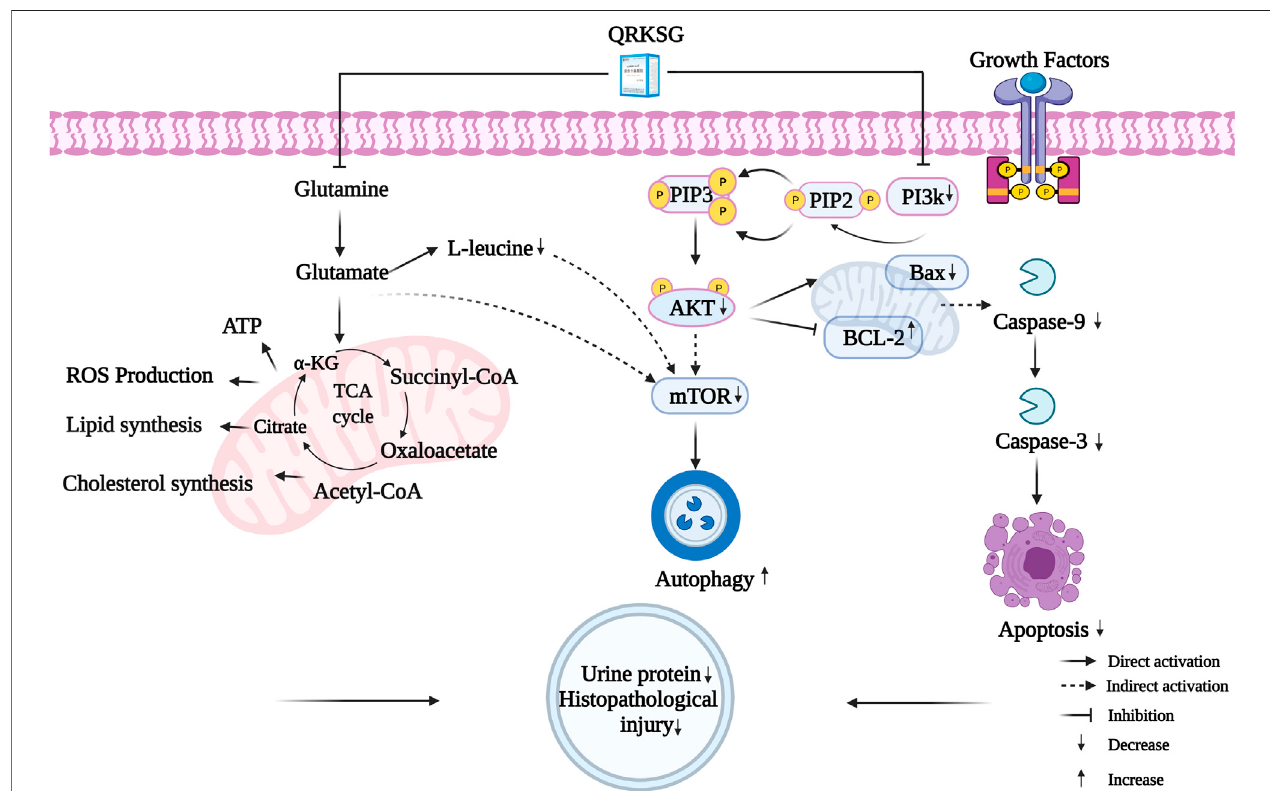
FIGURE 12 | The molecular mechanisms of QRKSG in treating